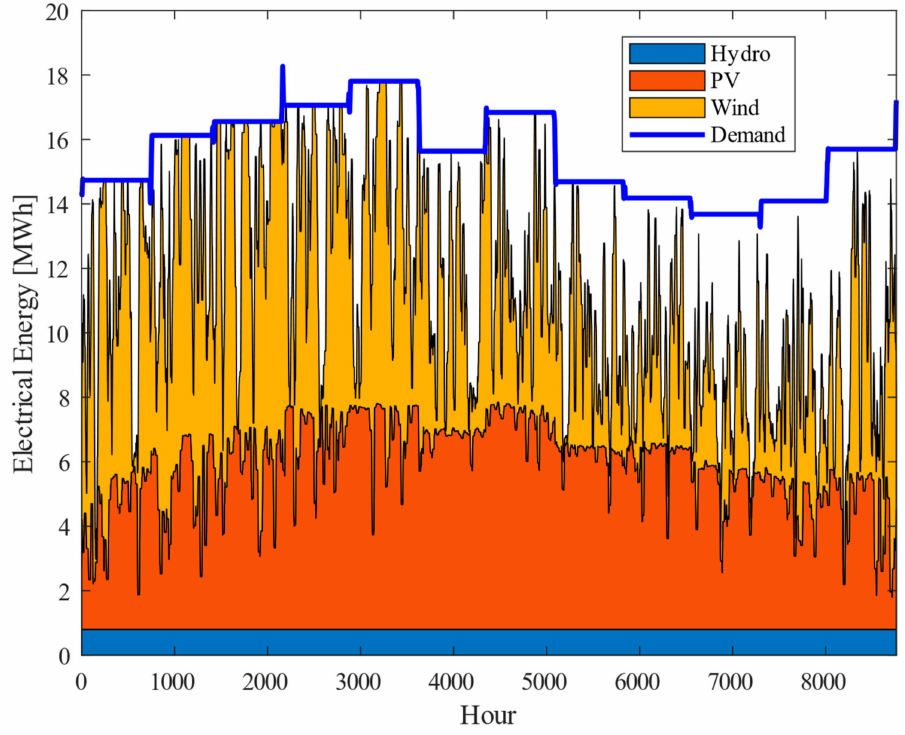
Figure 3. Demand met by the renewable energy system (RES) components without ESS (levelized cost 4 of electricity (LCOE) of 0.12 $ / kWh).